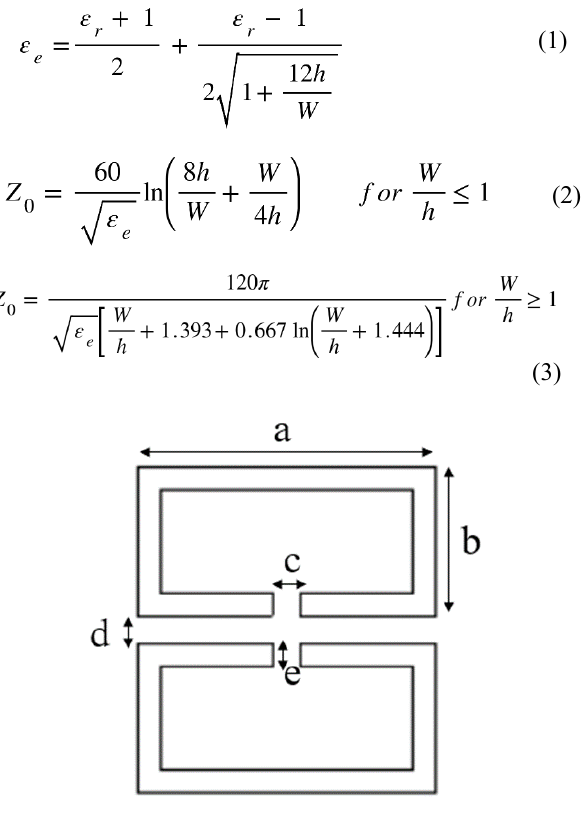
FIGURE 1. SYMMETRICAL RING RESONATOR UNIT